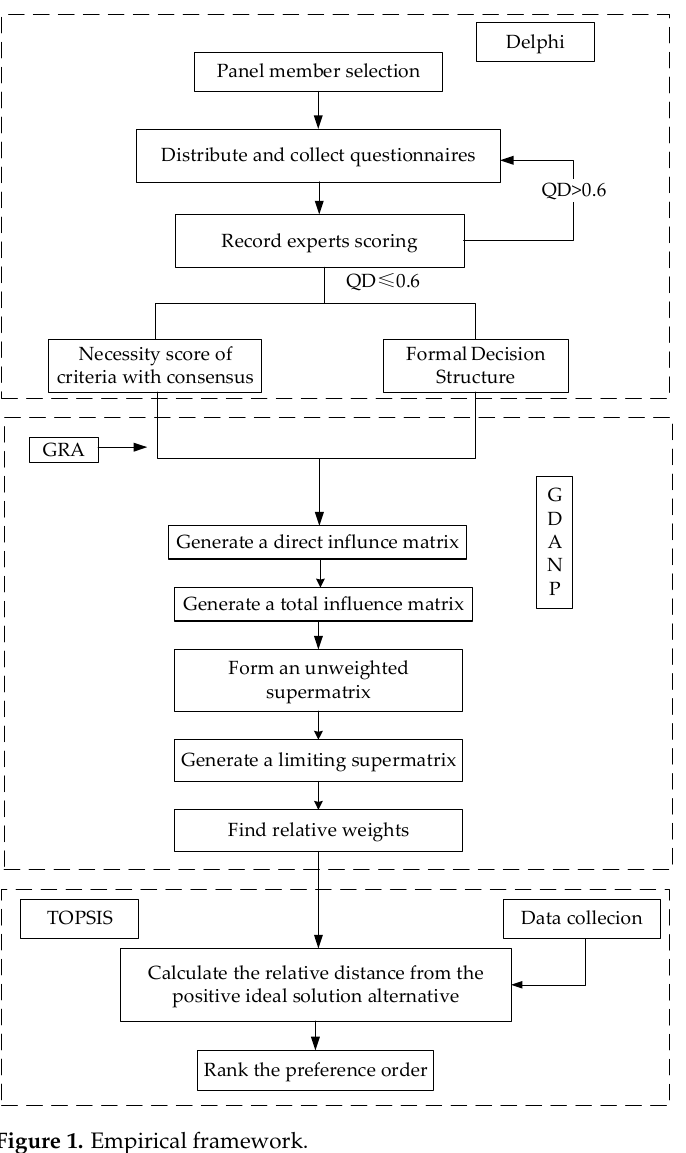
Figure 1. Empirical framework.